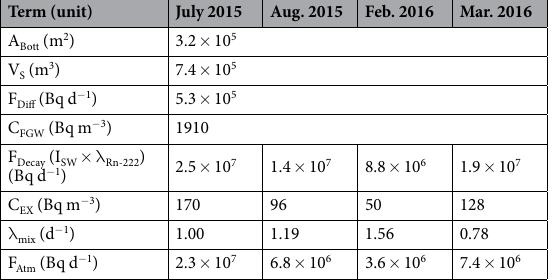
Table 1. The terms and values used in the simultaneous equation for the 222 Rn mass balance in Jocheon